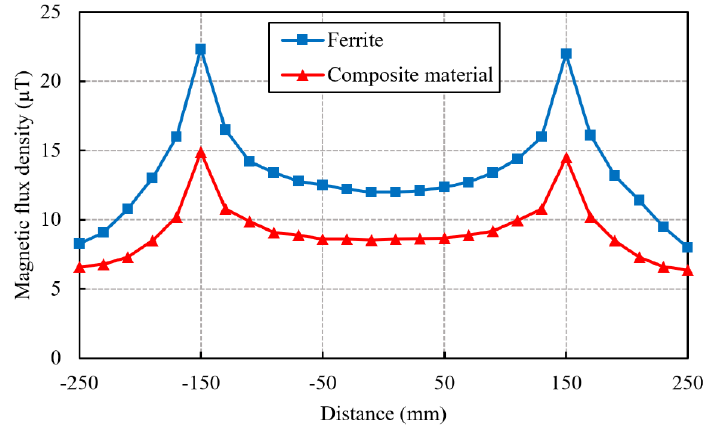
Figure 12. Magnetic flux density distribution at the measurement line.